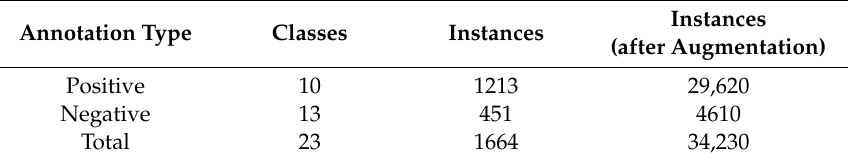
Table 1. Data annotation and augmentation.